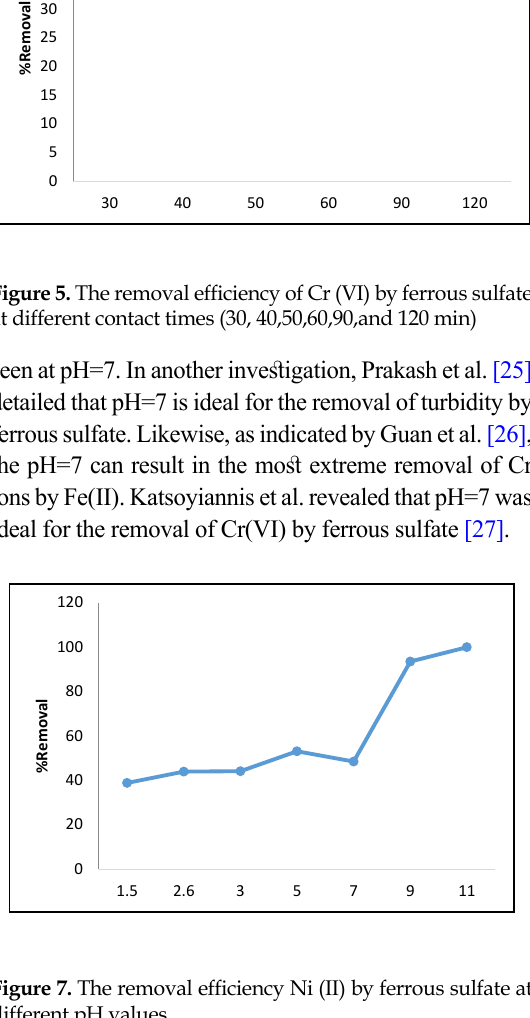
Figure 7. The removal efficiency Ni (II) by ferrous sulfate at different pH values